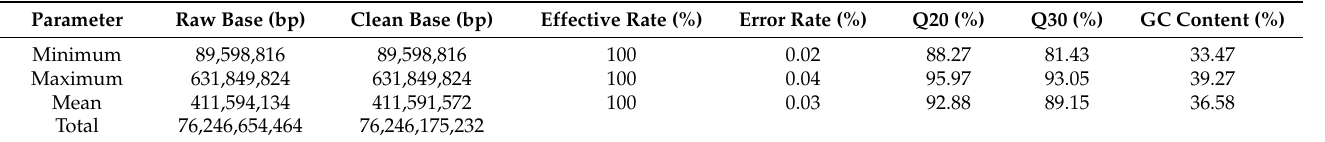
Table 1. Statistics of sequencing